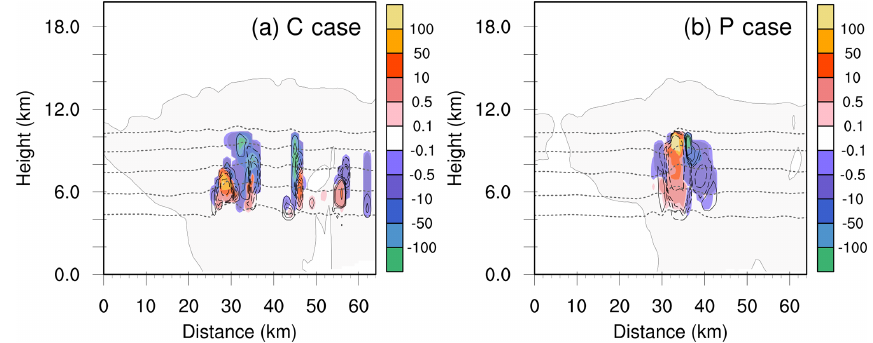
Figure 16. Vertical cross sections (south to north) at the locations shown in Fig. 4c and f of non-inductive (pCm − 3 s − 1 , shaded) and inductive (solid lines: 0.1, 0.5, 1pCm − 3 s − 1 ; dashed lines: − 0 . 1, − 0 . 5, − 1, − 5, − 10pCm − 3 s − 1 ) charging rates at the mature stage of the (a) C case (11:24UTC, Fig.4c) and (b) P case (11:54UTC, Fig. 4f). The 0, − 10, − 20, − 30 and − 40 ◦ C isotherms are shown by dashed gray